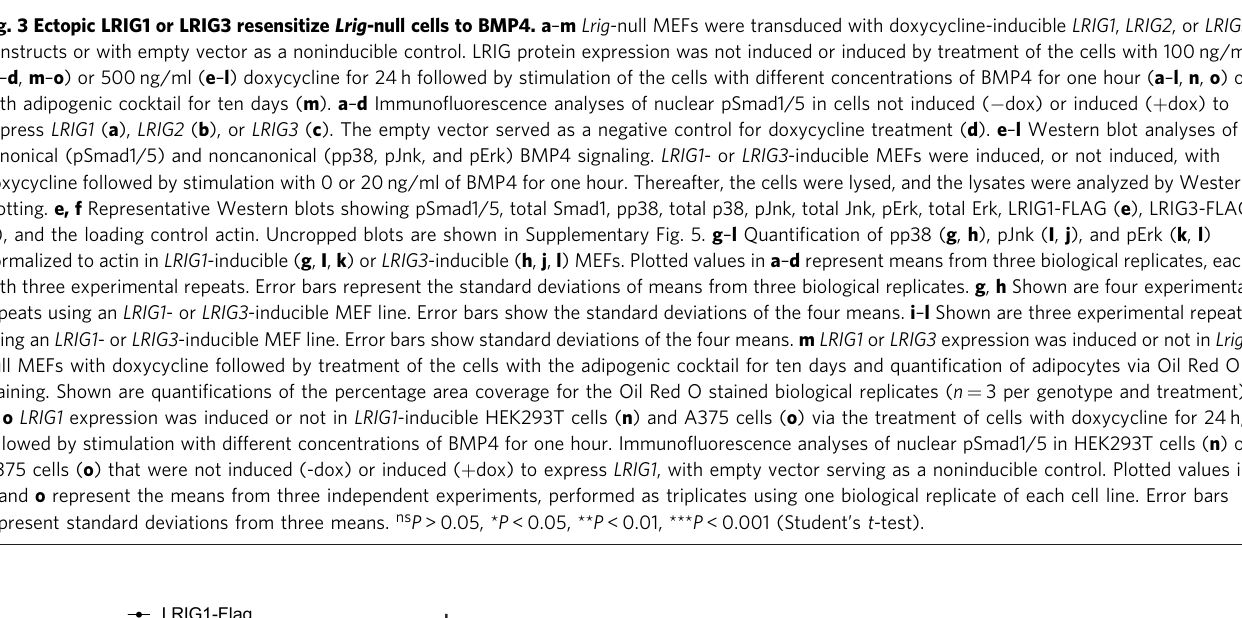
blotting. e, f Representative Western blots showing pSmad1/5, total Smad1, pp38, total p38, pJnk, total Jnk, pErk, total Erk, LRIG1-FLAG ( e ), LRIG3-FLAG normalized to actin in LRIG1 -inducible ( g , I , k ) or LRIG3 -inducible ( h , j , l ) MEFs. Plotted values in a – d represent means from three biological replicates, each